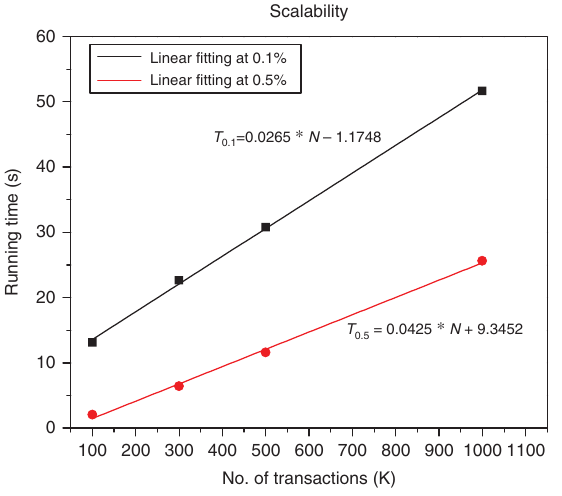
Figure 14: Scalability of the IMIDB Algorithm. Points are the computations presented in Table 13, and lines are the linear fittings for such